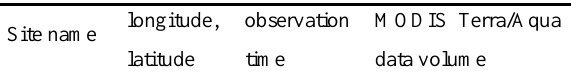
Table 1 . Statistics of AERONET ground stations in